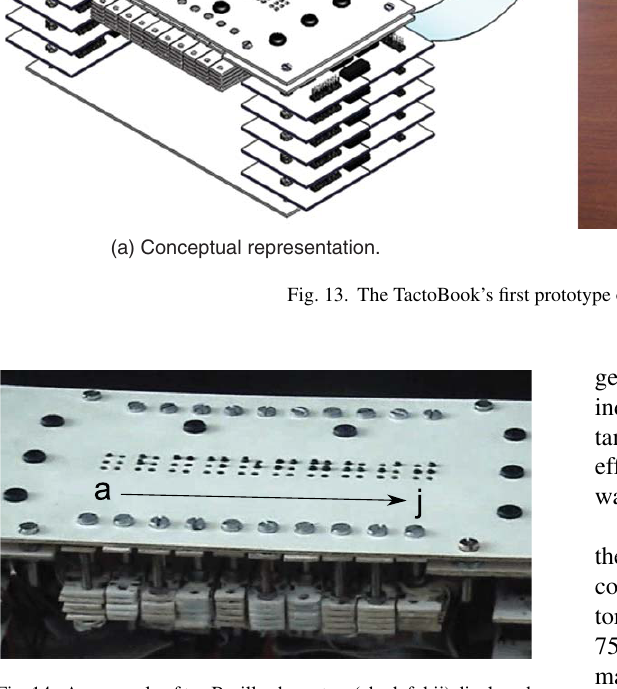
Fig.14. AnexampleoftenBraillecharacters(abcdefghij)displayed using the Braille